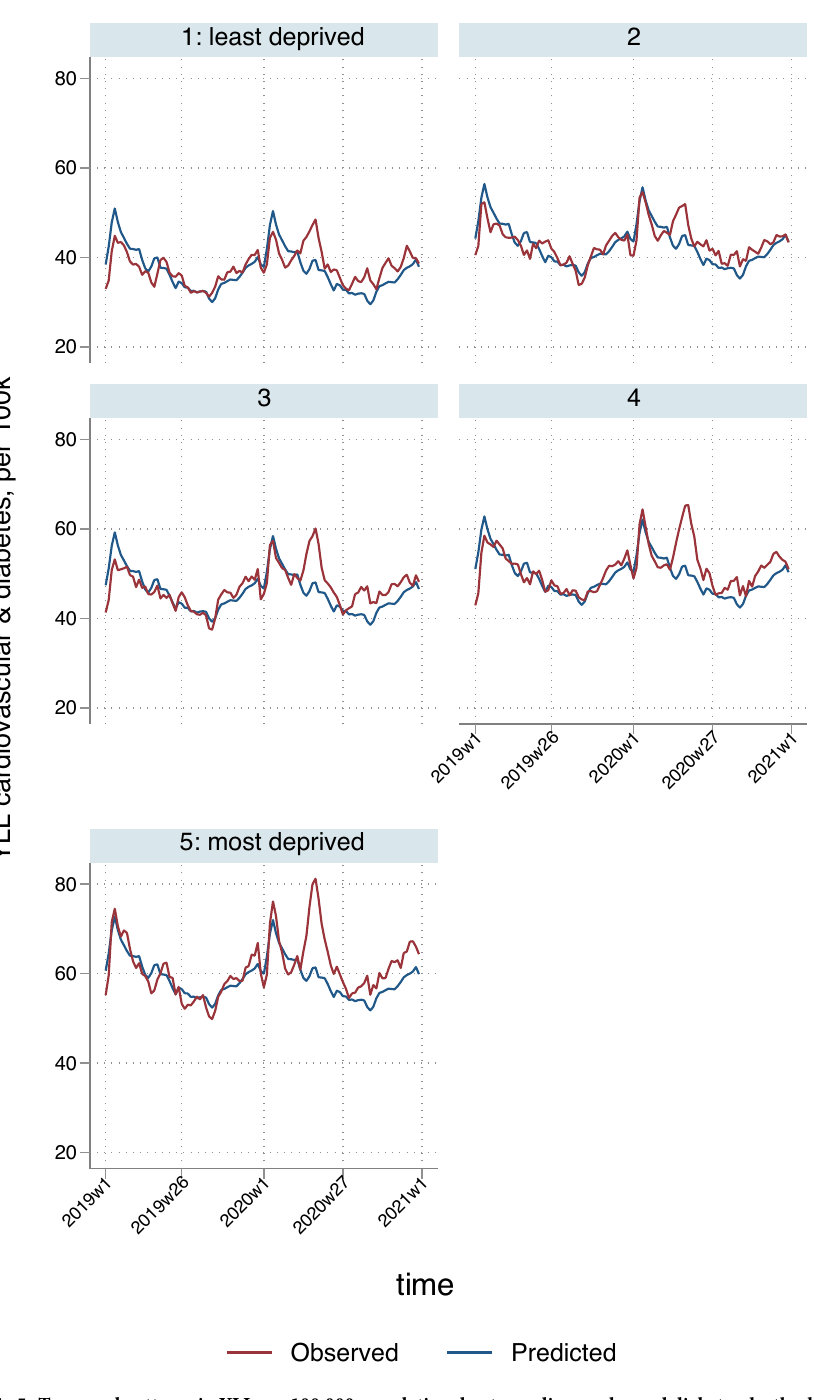
Fig 5. Temporal patterns in YLL per 100,000 population due to cardiovascular and diabetes deaths, by deprivation quintile � . � 3-week smoothed. YLL, years of life lost.